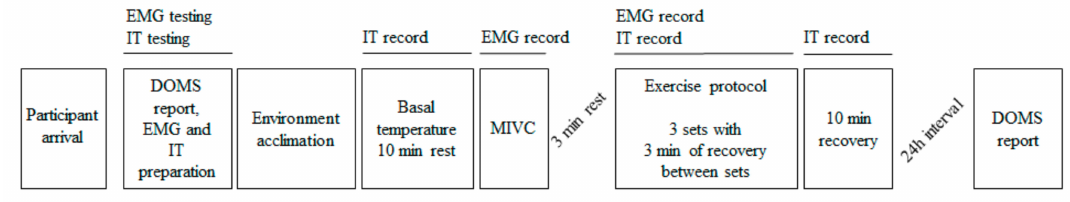
Figure 1. Flowchart of the study protocol. EMG: surface electromyography; IT: infrared thermography; MIVC: maximal isometric voluntary contraction; DOMS: delayed onset muscle